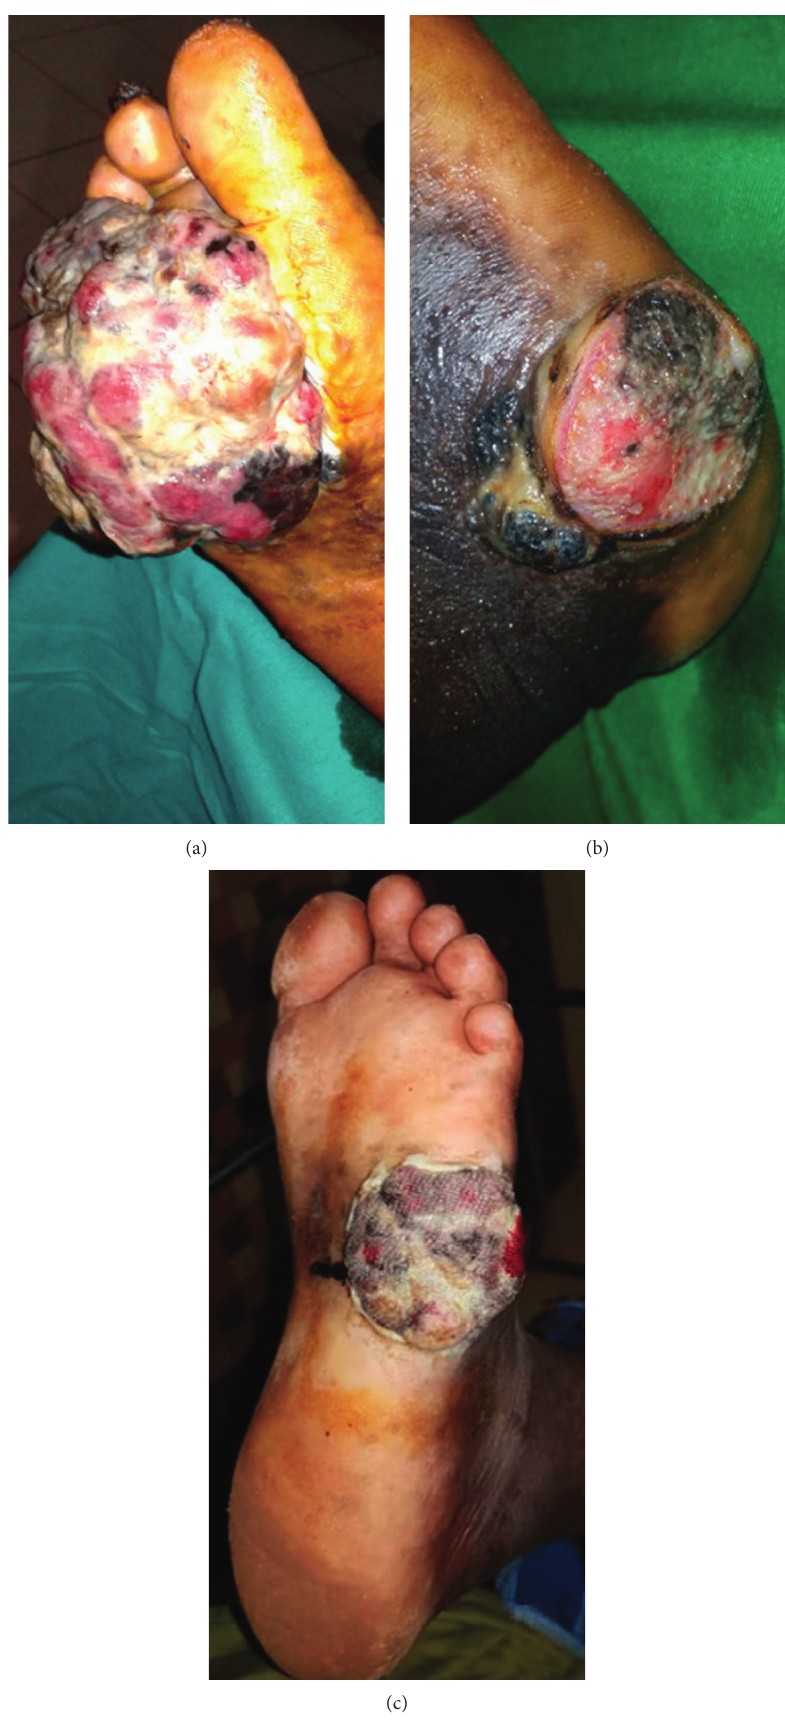
Figure 1: Ulceronodular plantar